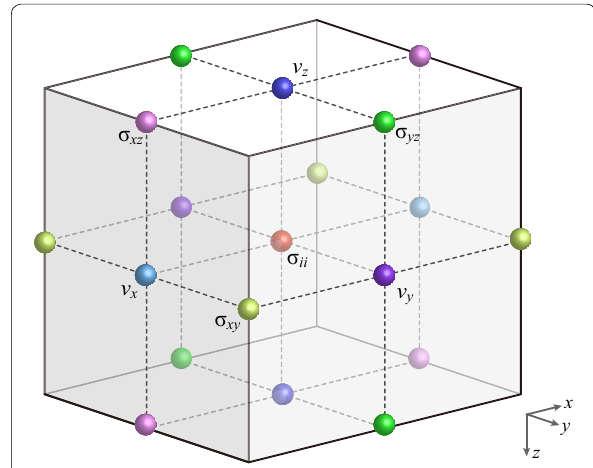
Fig. 3 Layout of the three-dimensional Cartesian coordinate staggered-grid adopted in this 100) in the =